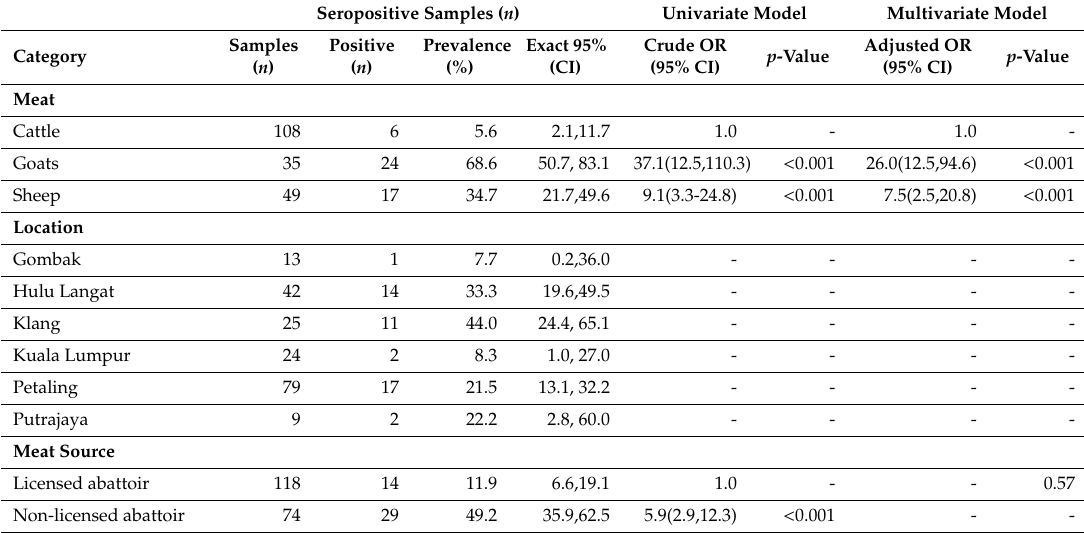
Table 4. Seroprevalence estimates with exact 95% confidence limits (CI), regression univariate and multivariate analysis for Toxoplasma gondii antibodies detected in meat samples of cattle, goat and sheep purchased from wet markets in Klang